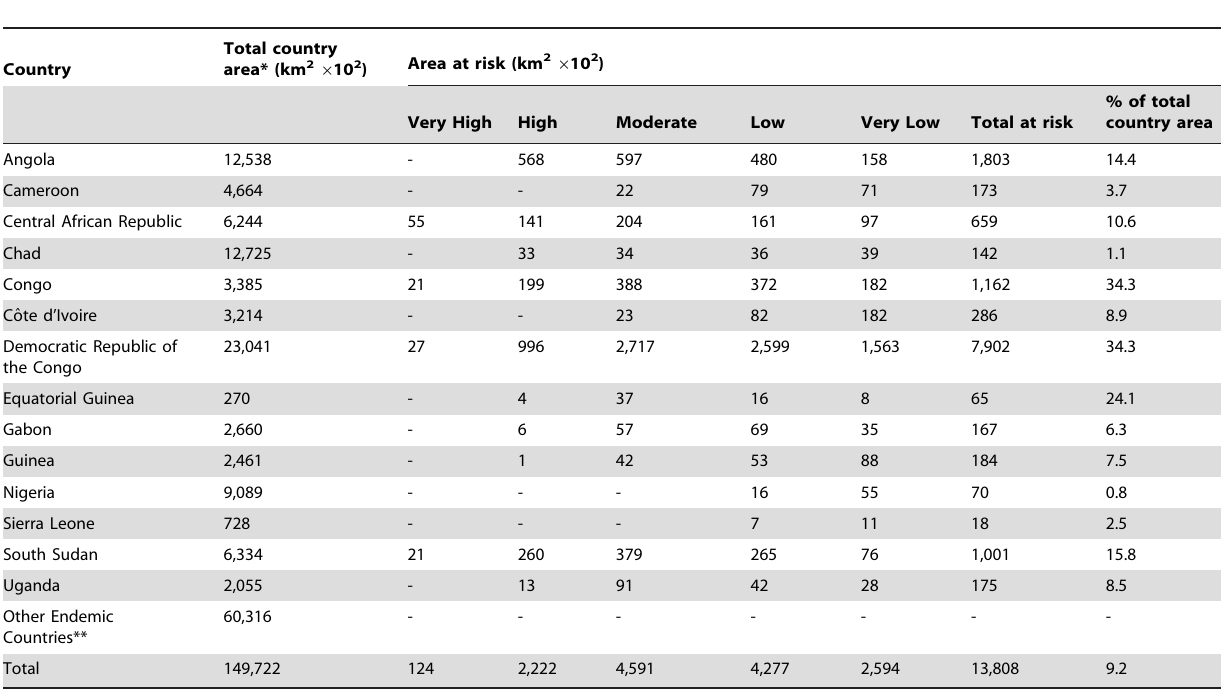
Table 2. Areas at risk of T. b. gambiense infection in western and central Africa (km 2 6 10 2 ).